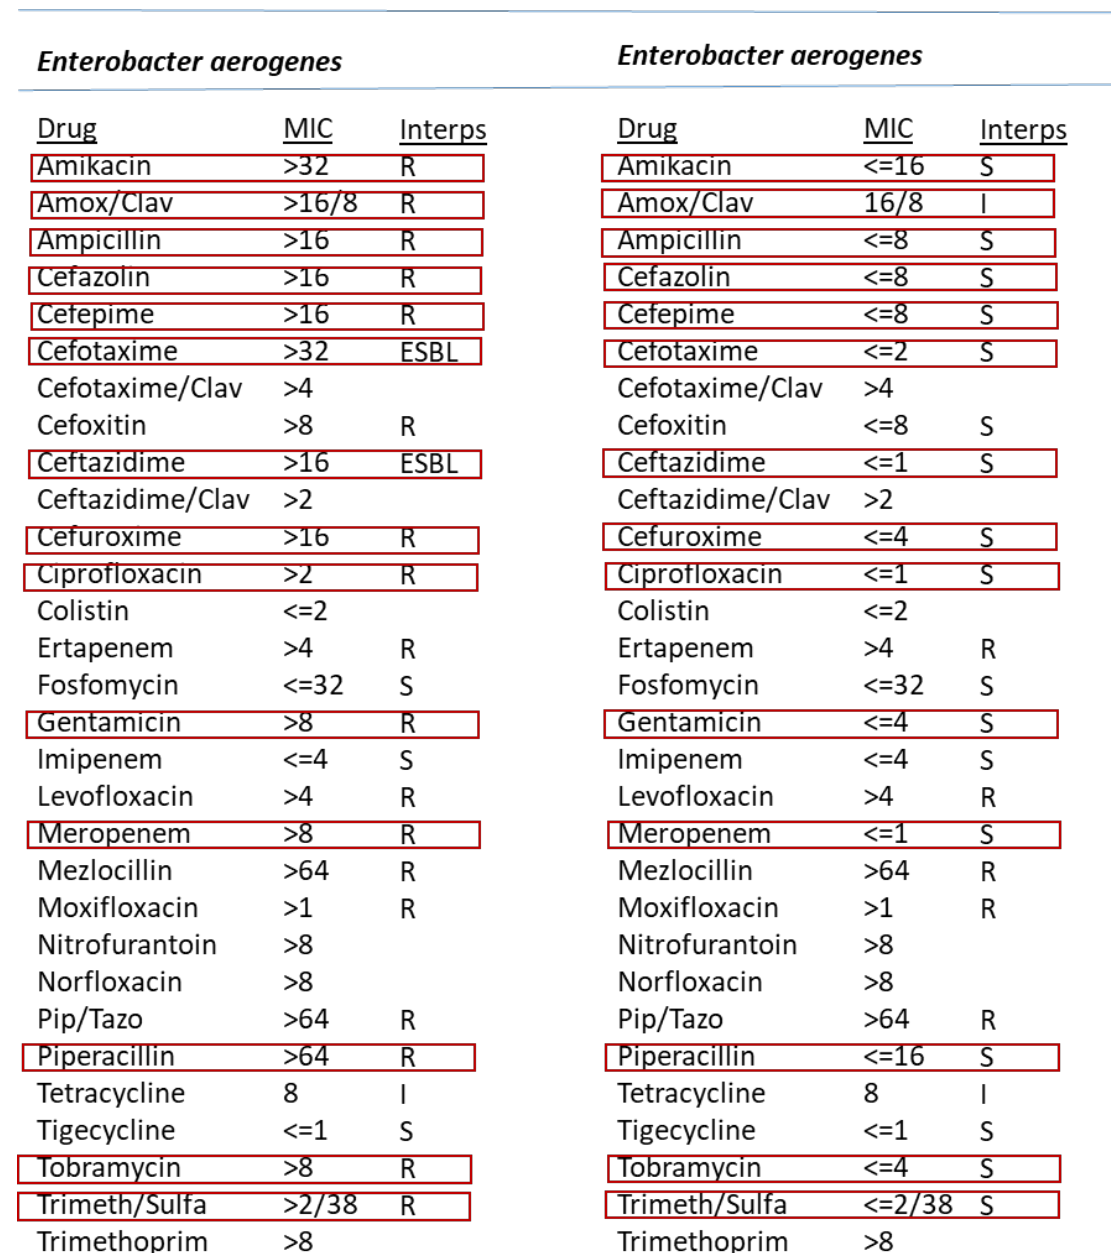
Figure 5. Demonstration of effect of bovine lactoferrin (bLF) on Carbapenemase producing (cephalosporin and carbapenem resistant) clinical Enterobacter